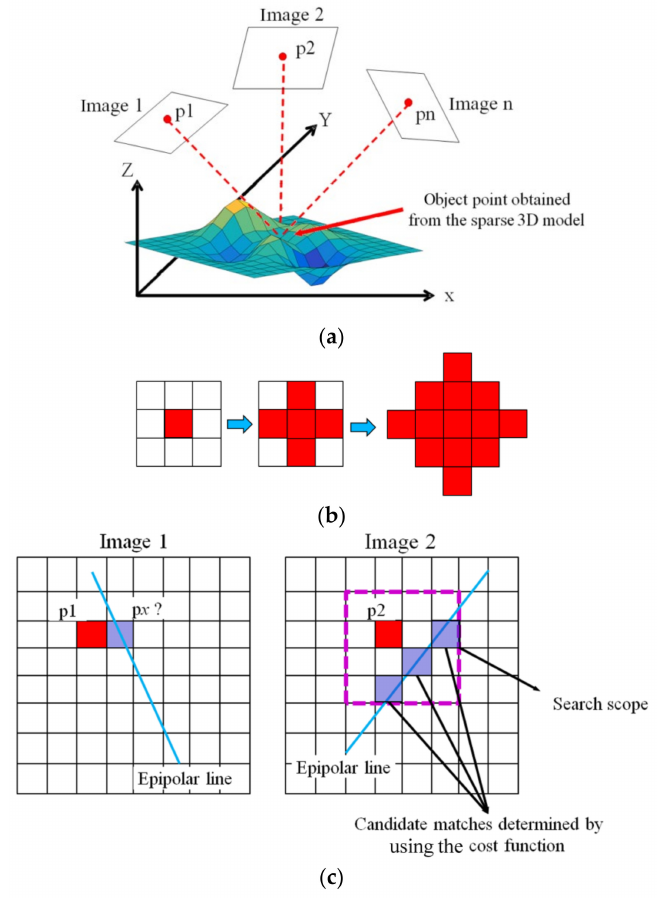
Figure 5. Region growing coupled with semi-global matching (SGM). ( a ) Object point backprojected onto multiple views. ( b ) Region growing in the four neighborhoods. ( c ) Process of candidate matches determined by using the cost function under the constraint of epipolar lines in two